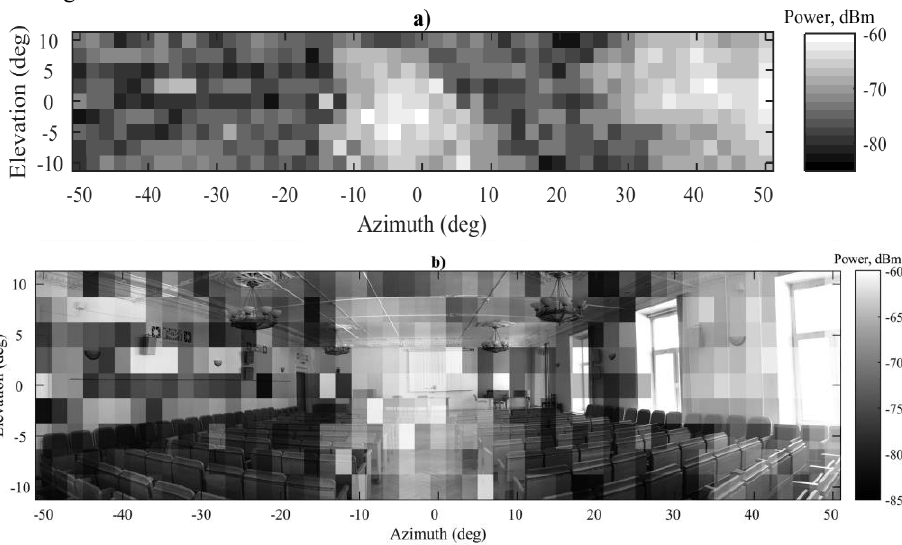
Fig. 3. The image of the hall in the microwave range without radiolight illumination (a), the composition of two images: one is in visible light and the other one is in radiolight